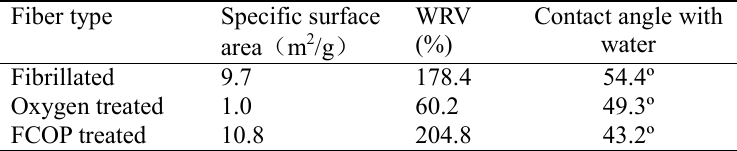
Table 3. Wettability and hydrophilic properties of modified